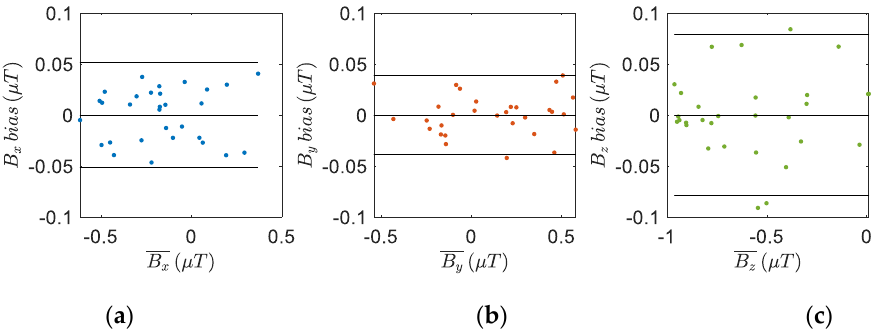
Figure 8. Bland–Altman plots to assess the agreement of the tibial IMU with the commercial, gold standard, Xsens system on the ( a ) x-axis, ( b ) y-axis and ( c ) z-axis of the two magnetometers. The horizontal axis is the average magnetic field strength of the two instruments (magnetometer units), while the vertical axis is the difference between the two. The solid horizontal lines are the average difference and the limits of